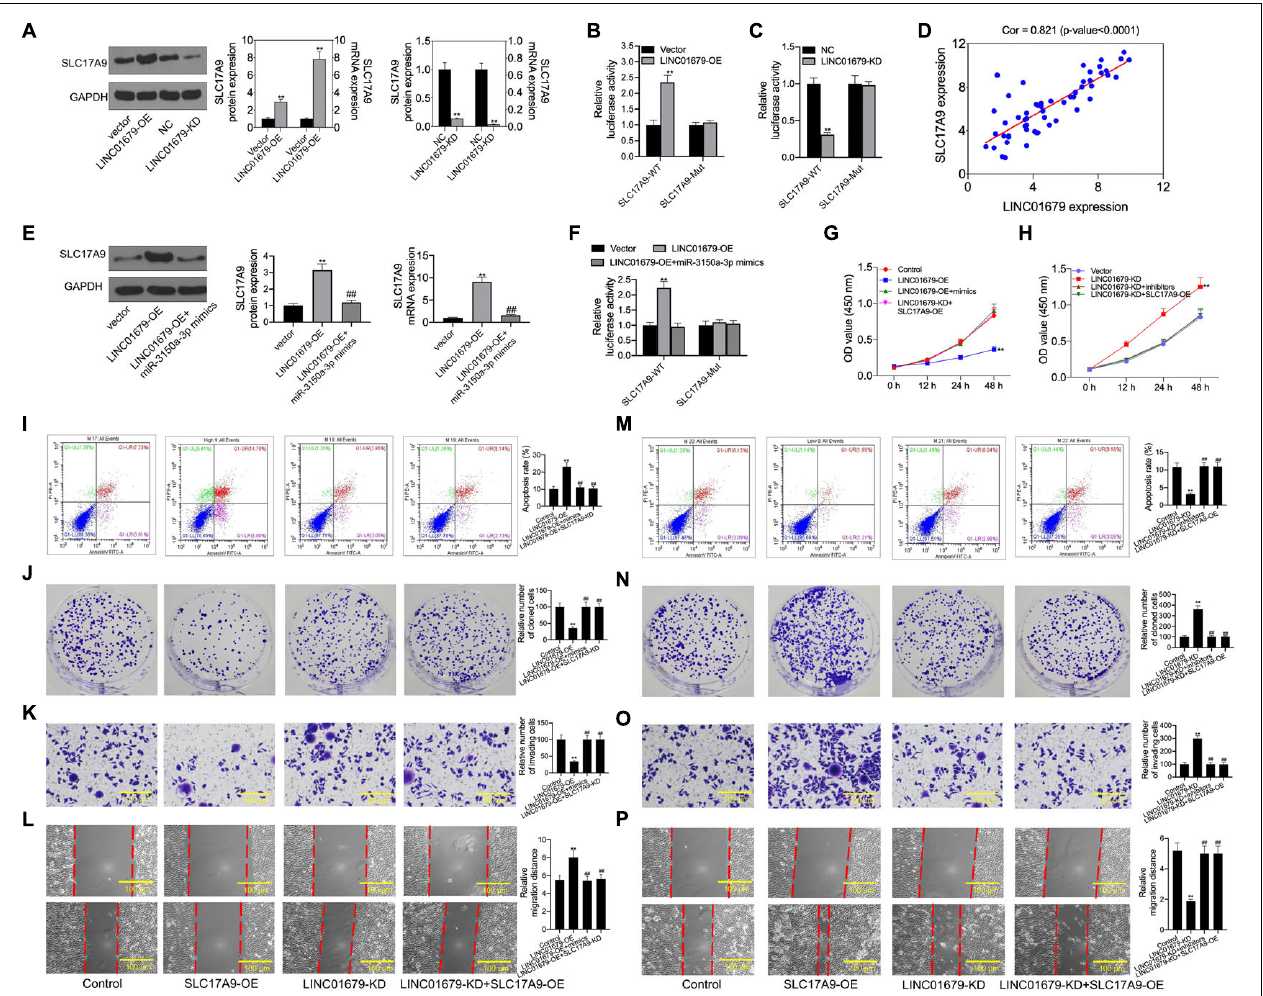
FIGURE 10 | SLC17A9 involved in the LINC01679-mediated inhibition of PCa progression. (A) SLC17A9 expression in PCa cell lines transfected with LINC01679-siRNA or LINC01679-expressing vector measured through qRT-PCR and Western blotting. (B,C) Binding of SLC17A9 to LINC01679 verified by dual-luciferase reporter gene assay. (D) The correlation analysis between LINC01679 expression and SLC17A9 expression. (E) SLC17A9 expression in PCa cell lines co-transfected with LINC01679-expressing vector and miR-3150a-3p mimics by measured through qRT-PCR and Western blotting. (F) The interaction among SLC17A9, miR-3150a-3p, and LINC01679 verified by dual-luciferase reporter gene assay. Cell viability (G,H) , cell apoptosis (I,M) , proliferation (J,N) , invasion (K,O) , and migration (L,P) of cells after transfection with LINC01679-expressing vector and siRNA-SLC17A9 or LINC01679-expressing vector and SLC17A9-expressing vector determined by CCK-8, flow cytometry, colony formation, Transwell, and scratch assays. Each independent assay was conducted in triplicate; ** vs. control group, p < 0.01; ## vs. LINC01679-OE